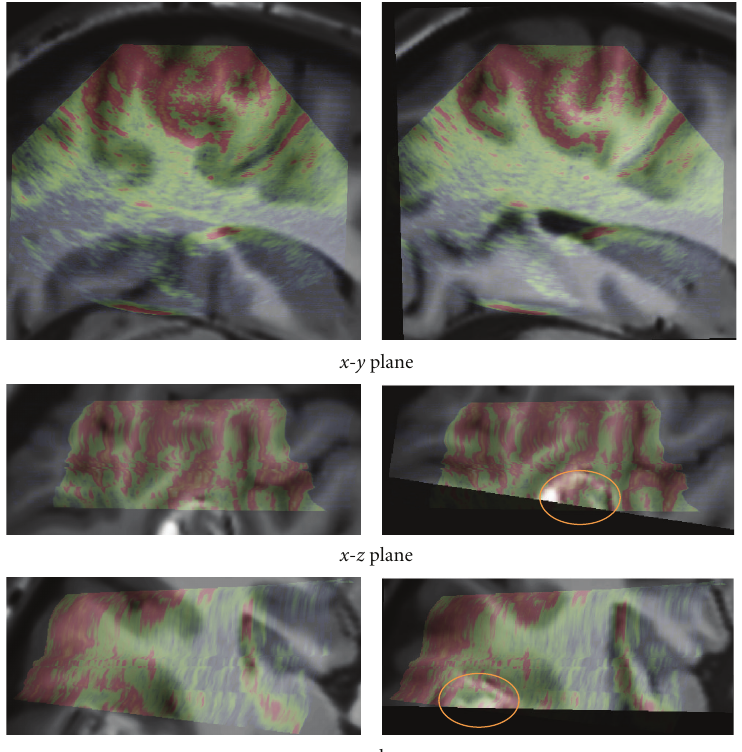
Figure 5: Patient 1. Left: registration given by the neuronavigation system. Right: the result after correction with our registration approach. The low intensities of US images are in green and the high in red. For this case, even if the lesion was not entirely included in the US volume, the proposed registration procedure converged. The location of the lesion is indicated by ellipses on the fused image after